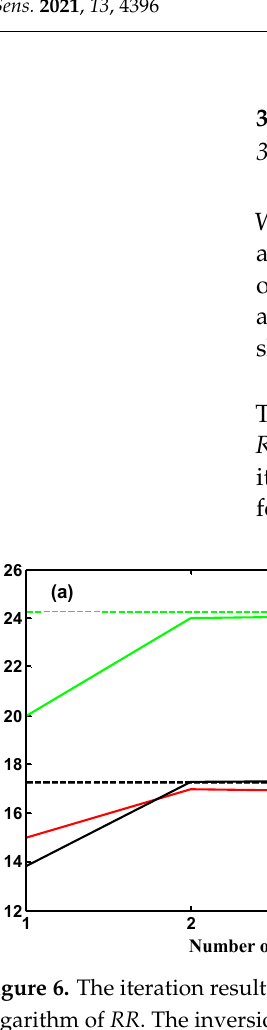
Figure 5. Results for the relative error with changes in the initial parameters: ( a ) lidar constant at 532 nm ( C 532 ); ( b ) lidar constant at 1064 nm ( C 1064 ); ( c ) radar constant ( C rad ).